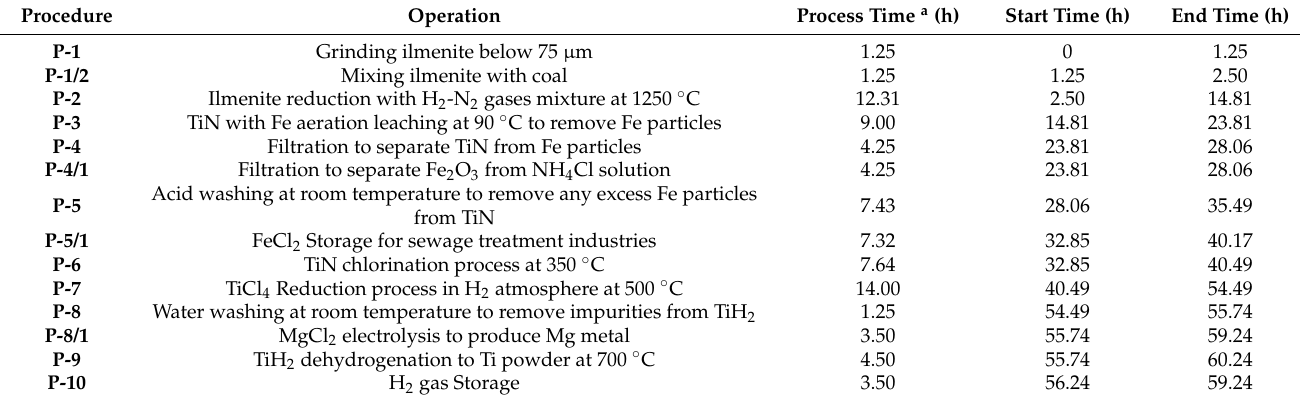
Table A1. Scheduling summary for the simulation model of 1000 kg